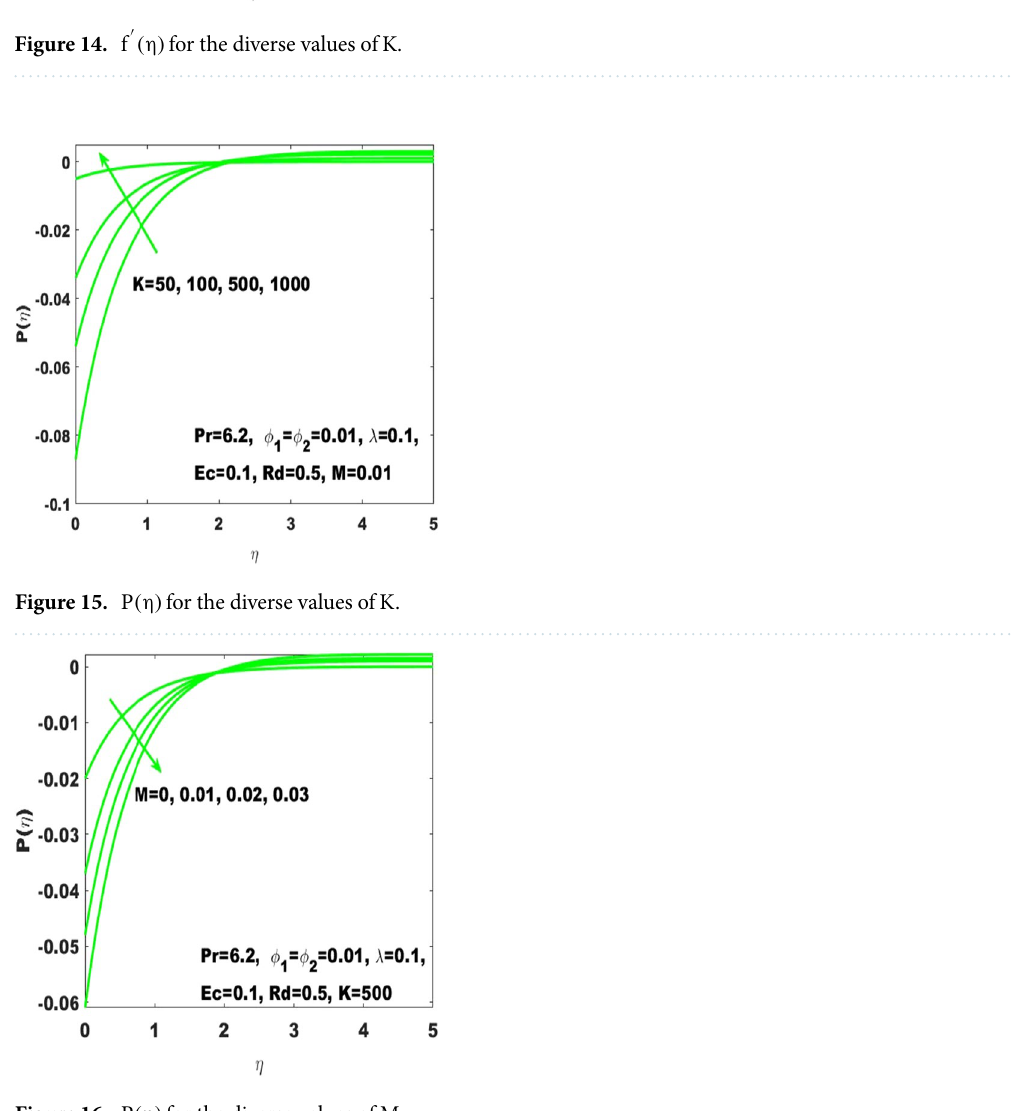
Figure 16. P ( η ) for the diverse values of